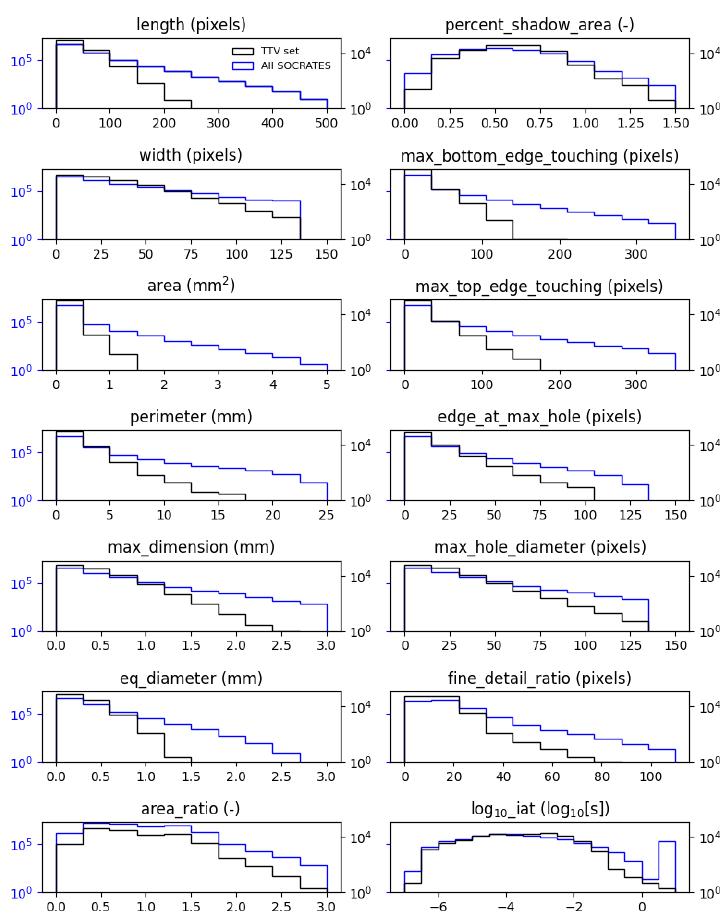
Figure A2. Histograms of particle features are shown for the TTV set (black) and for SOCRATES flights RF01–RF14 (blue), which are analyzed in Sects. 4 and 5. touching_edge is not shown here because it is a binary